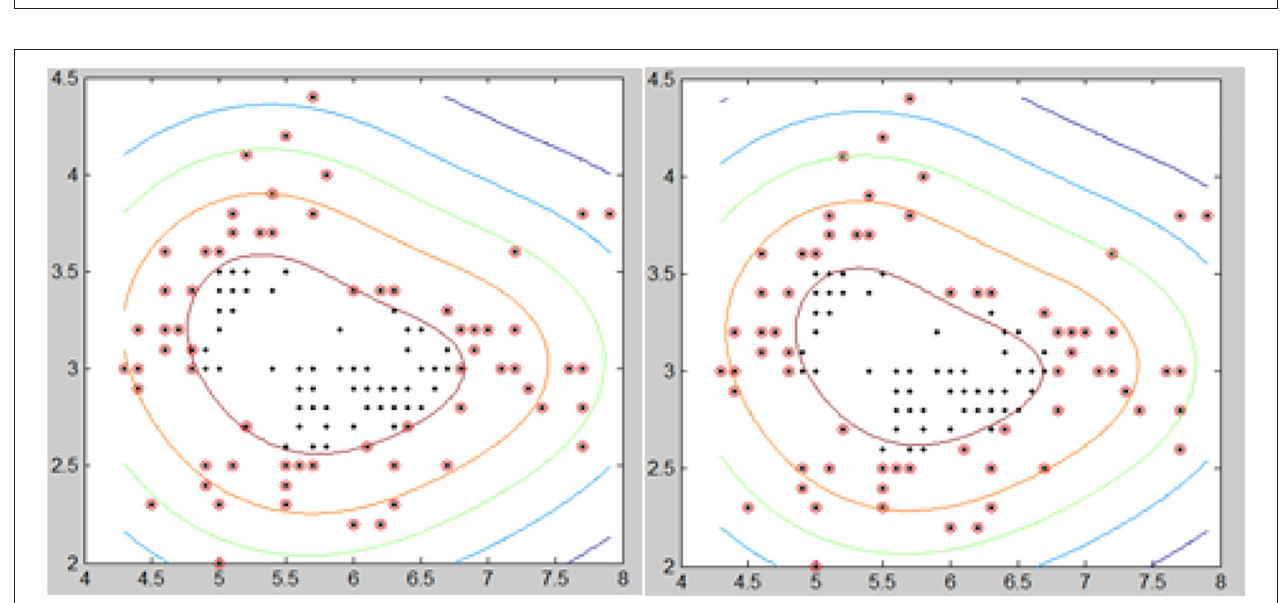
FIGURE 7 | BEC kernel (Left) and Gaussian kernel (Right) for random nodes.